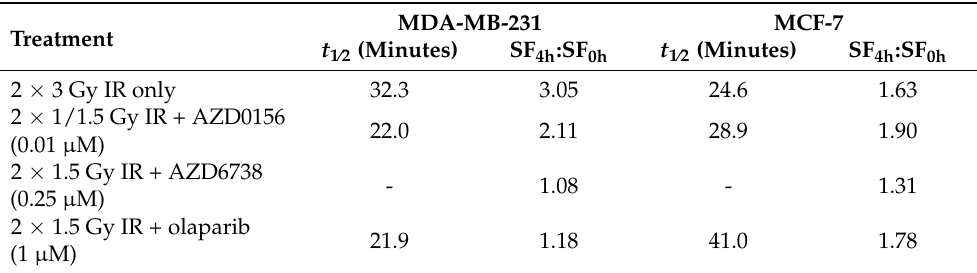
Table 3. SLD repair half-time ( t 1 ⁄ 2 ) in minutes and ratio of the surviving fraction after 4-h fractionated IR to non-fractionated IR (SF 4h :SF 0h ) of MDA-MB-231 and MCF-7 cells treated with IR only and in combination with AZD0156 (0.01 µM), AZD6738 (0.25 µM) or olaparib (1 µM). In the AZD0156 treatment group, MDA-MB-231 cells were irradiated with two 1 Gy doses, while MCF-7 cells were irradiated with two 1.5 Gy doses. t 1 ⁄ 2 values were estimated from the survival curves in Figure 8, and values for the two 1.5 Gy IR + AZD6738 (0.25 µM) groups were unavailable due to ambiguous or interrupted fits with the one-phase exponential model. Data were obtained from three independ- ent experiments performed in duplicate or triplicate wells.